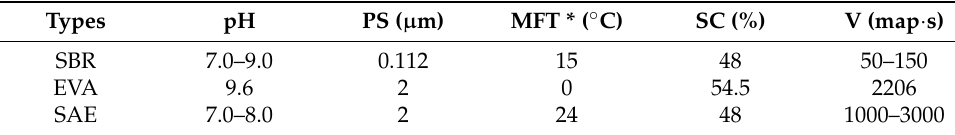
Table 2. Characteristic parameters of polymer